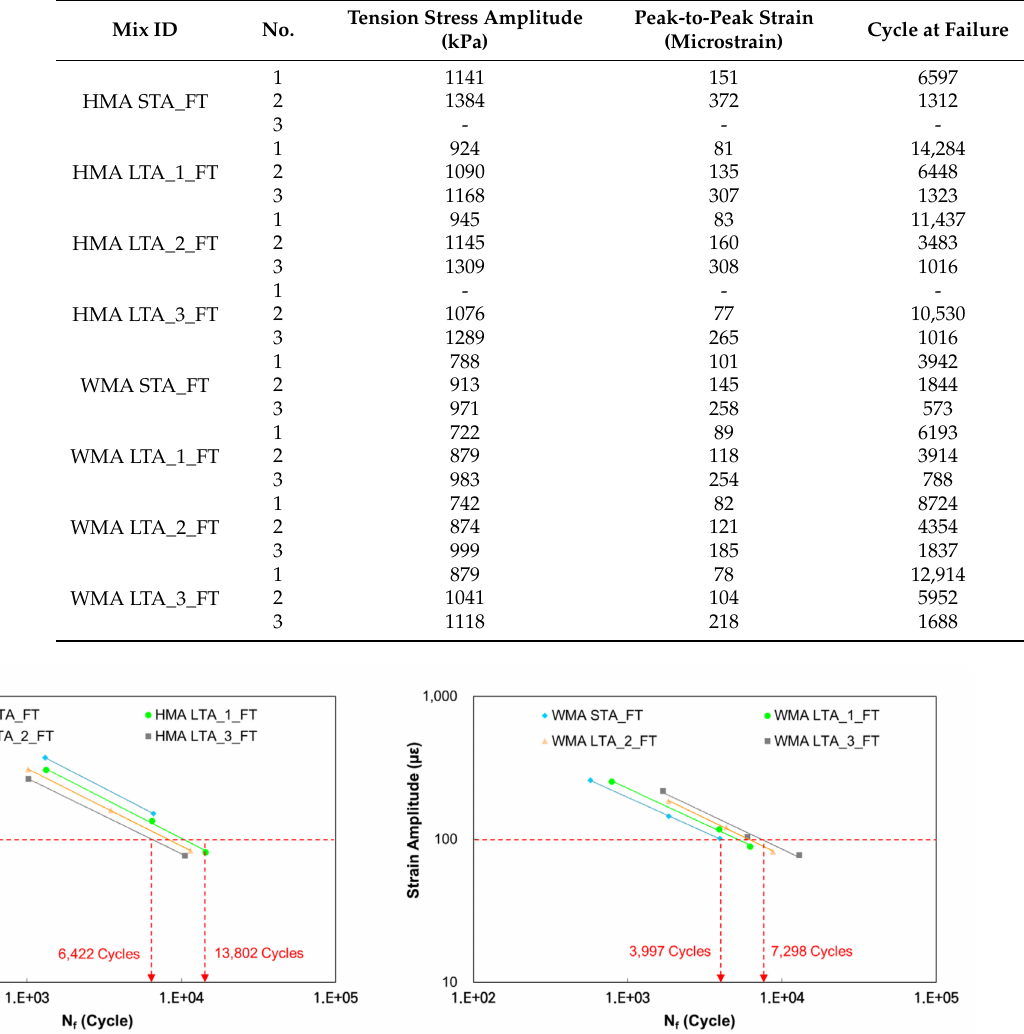
Table 7. Fatigue cracking performance results of HMA and WMA due to moisture damage for each stage of aging.